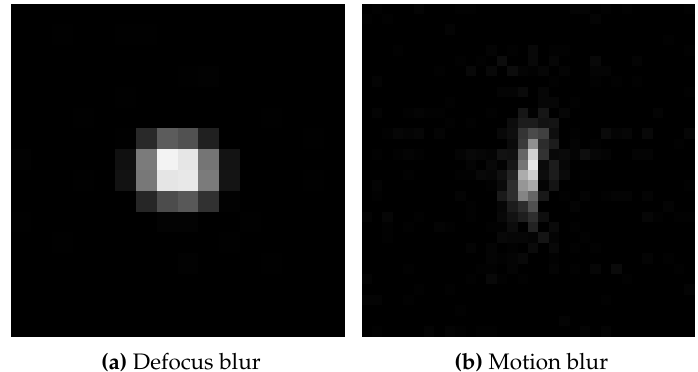
Figure 13. Blur kernels recovered by blind deconvolution, ( a ) shows the 15 × 15 blur kernel recovered from the defocused image in Figure 11a, while restoring Figure 11b; ( b ) shows the 32 × 32 blur kernel recovered from image with motion blur in Figure 12a, while restoring Figure 12b. Values between 0 ( black ) 1 ( white ), values scaled for better